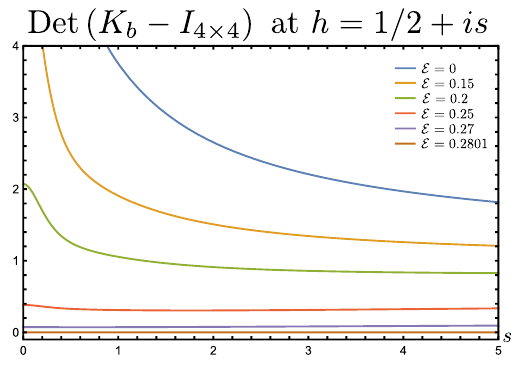
+ is, where a complex mode is indicated by location 2 at which point there is also a c , + is 2